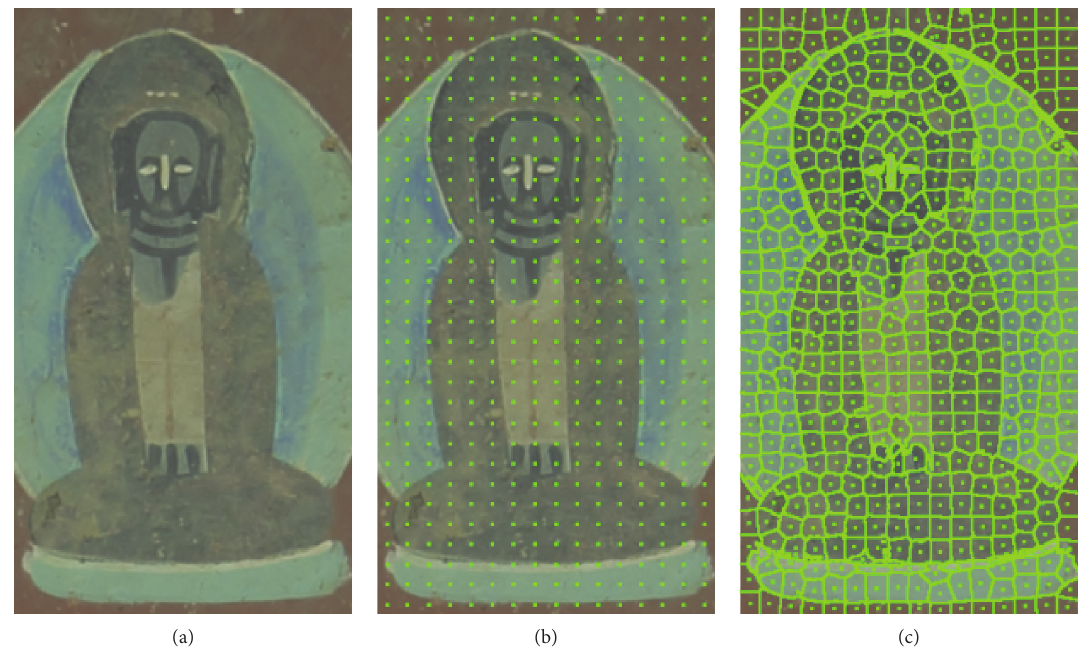
Figure 1: Superpixel segmentation of the visible spectral image. (a) Original image. (b) Initial centers. (c) Final